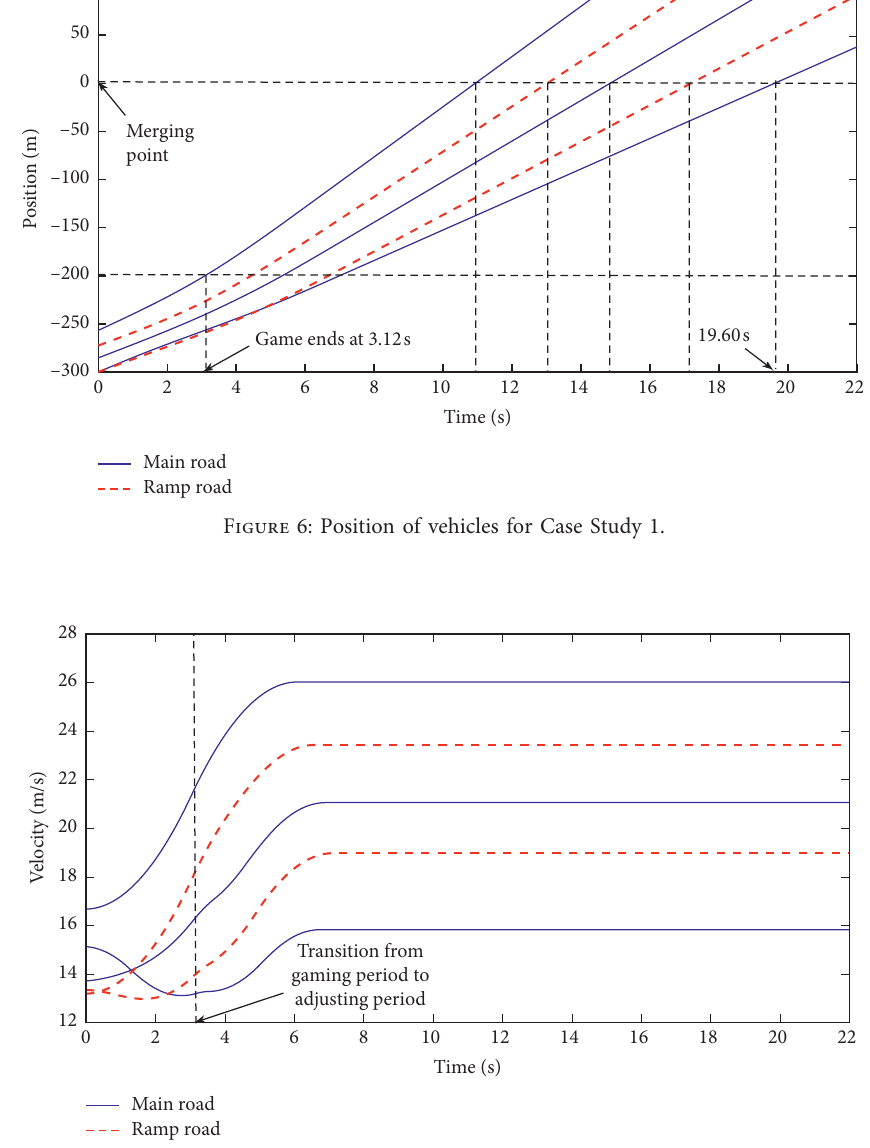
Figure 7: Velocity of vehicles for Case Study